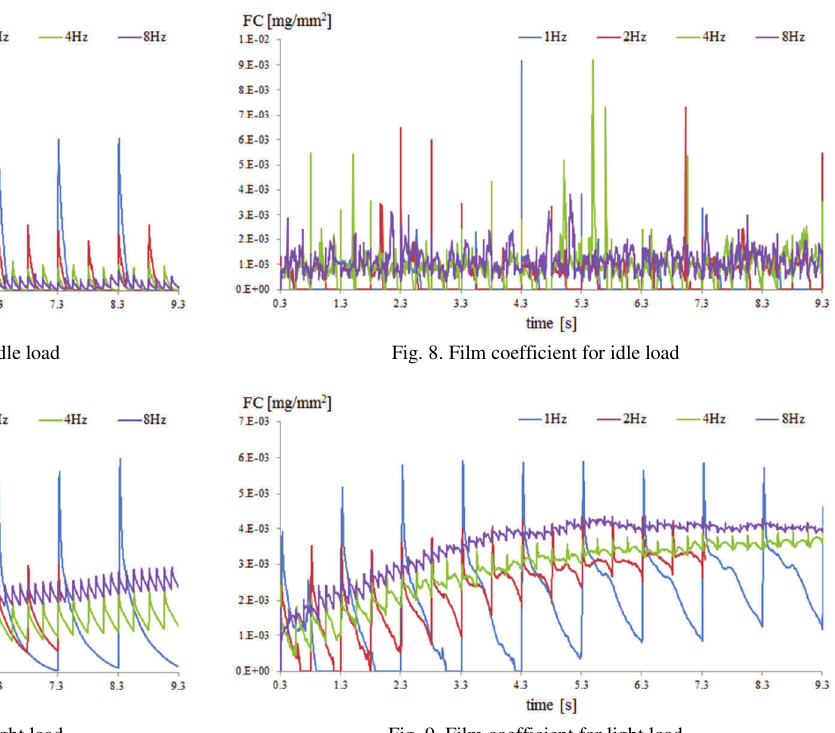
Fig. 9. Film coefficient for light load